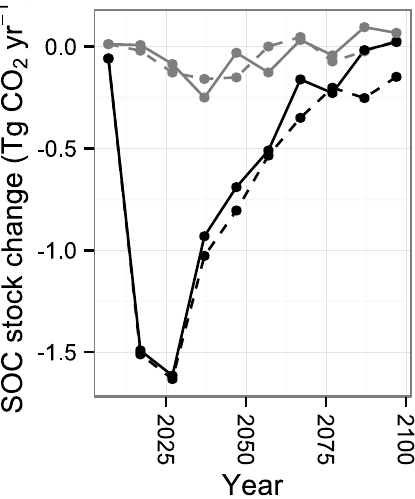
Figure 9. Relative changes in soil organic carbon (SOC) stock in agricultural lands in Japan obtained by baseline-based accounting defined as differences in estimated changes in SOC stock between two different future agricultural activity scenarios, MAFF-BP and BAU, with regarding BAU as baseline scenario (i.e. MAFF-BP mi- nus BAU). Negative and positive value on vertical axis indicates rel- ative removal and emission, respectively, of CO 2 . Solid and dashed line indicates future climate projections, MIROC-H & A1B and FGOALS & B1, respectively. Gray and black colour indicates fu- ture land-use change scenario, abandonment and urbanization, re-